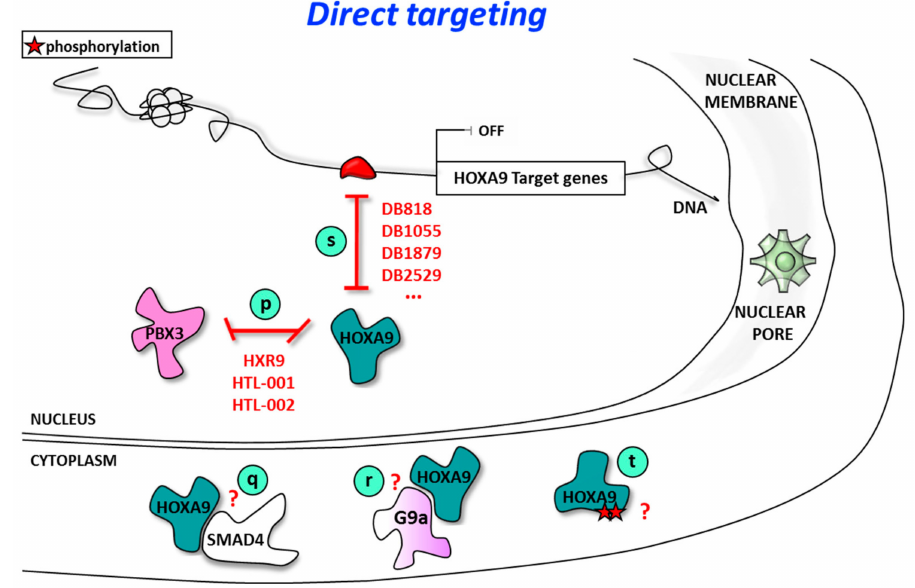
Figure 3. Direct targeting of HOXA9 function: inhibition of protein / protein or protein / DNA interaction to block HOXA9 transcriptional activity in